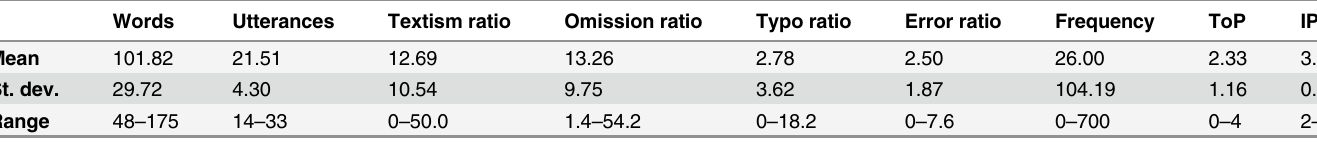
Table 5. Means, standard deviations and ranges of texting characteristics.